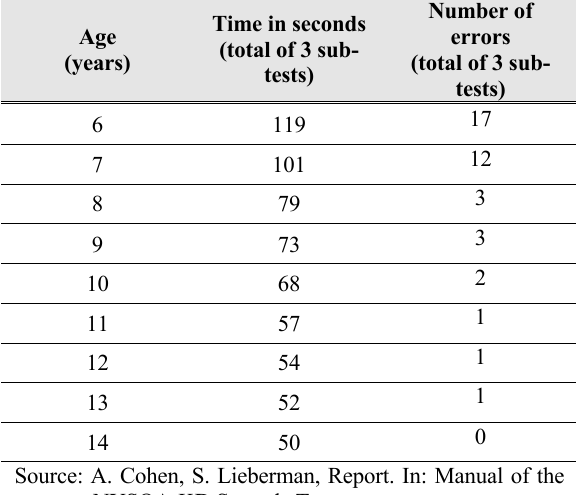
K-D test results